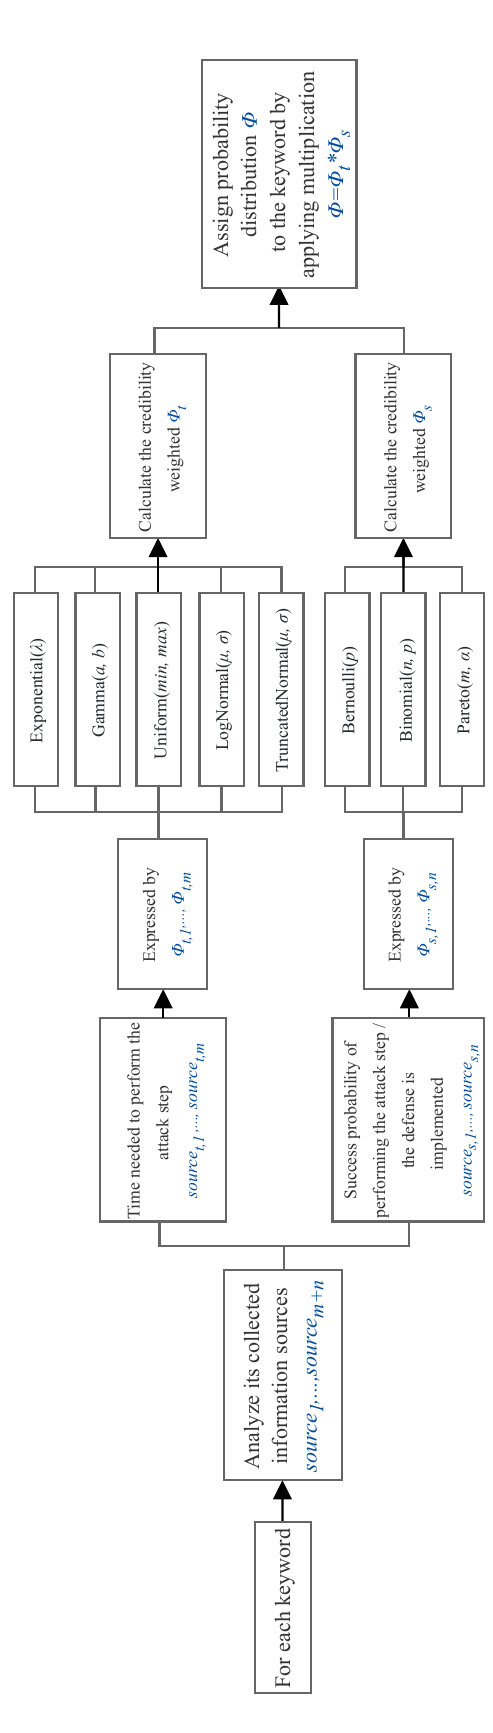
Figure 7. Overview of the interpreting and transforming information to probability distributions